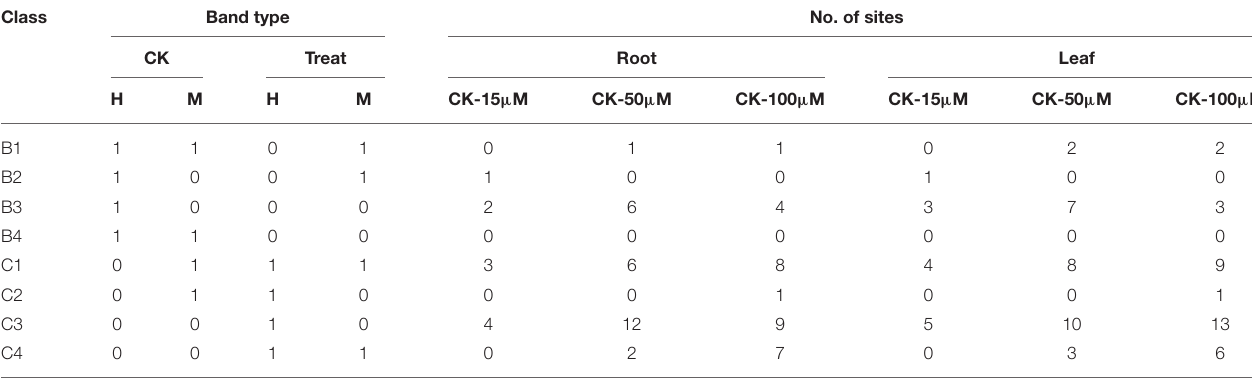
TABLE 2 | Change in methylation pattern in R. glutinosa under 5-azaC treatment. Class Band type No. of sites CK Treat Root Leaf CK-15 µ M CK-50 µ M